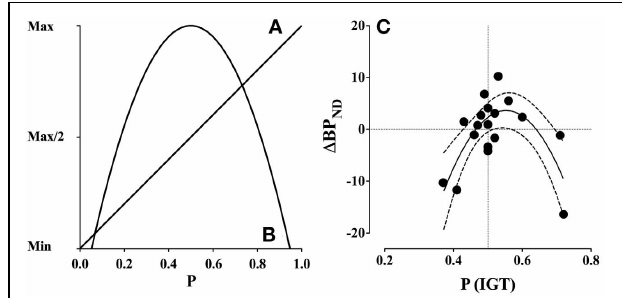
FIGURE 3 | Expected value and uncertainty as a function of reward probability and dopamine release ( (cid:2) BP ND ). (A) Expected value is a linear function of reward probability, where the expected value is minimal at p = 0 . 0 and maximal at p = 1 . 0. (B) Uncertainty, defined as variance, is a quadratic function of reward probability, where uncertainty is maximal at p = 0 . 5 and minimal at p = 0 . 0 and p = 1 . 0. (C) Gambling disorder sufferers (PG) show an inverted U-shaped function between binding potential ( (cid:2) BP ND ) in the combined striatum and probability of selecting advantageous decks [P(IGT)]. The interaction is significant ( p < 0 . 005) and accounts for 53.4% of the variation, R 2 (18) = 0.534. The dashed lines indicate confidence intervals (95% CE). Positive (cid:2) BP ND values suggest dopamine release, because dopamine occupies more receptors during